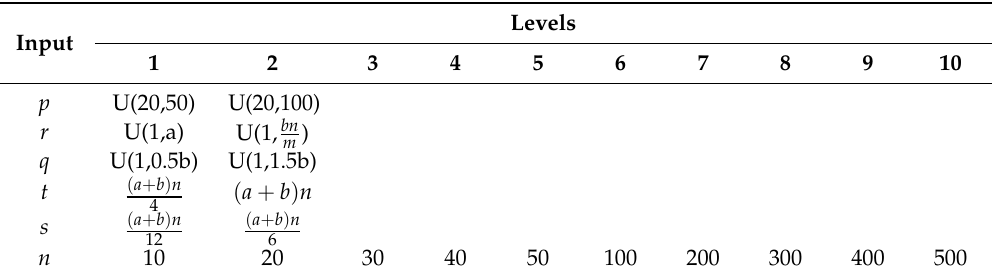
Table 3. Experimental characteristics of the generated instances.